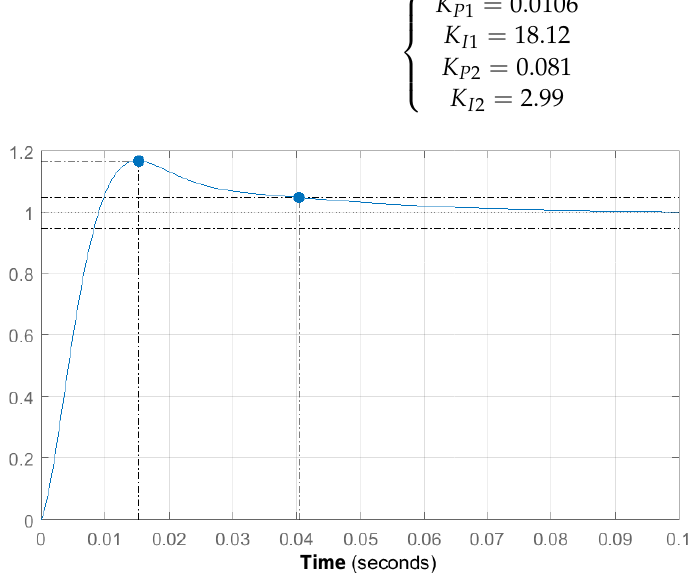
Figure 13. The desired output step response of the cascade PI–PI control of the 2IBC.